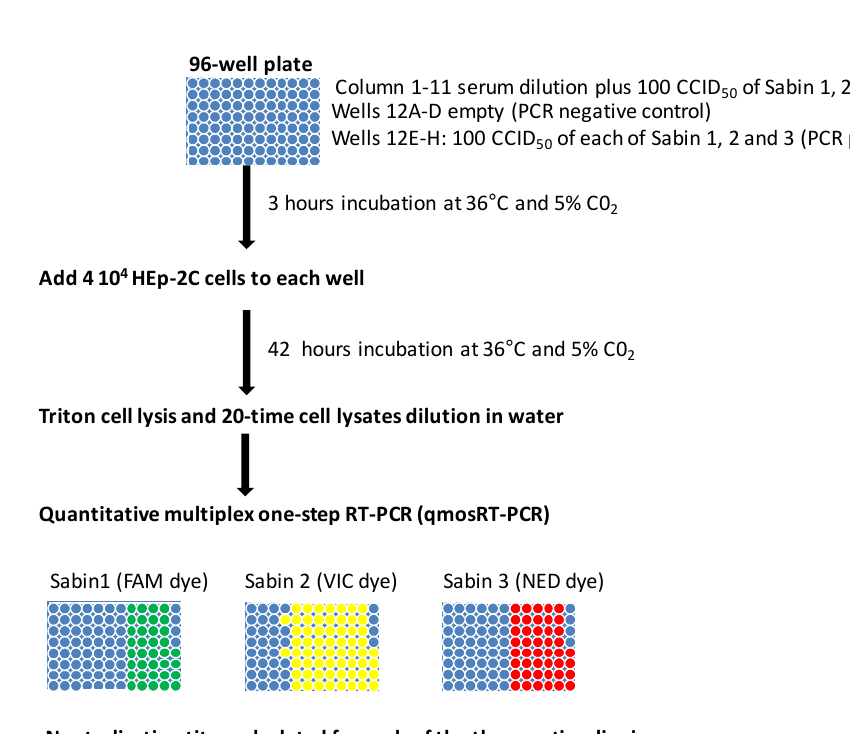
Table 2. Titration of human anti-poliovirus sera type 1, 2 and 3 with multiplex PCR-based neutralization (MPBN) and conventional neutralization assays.